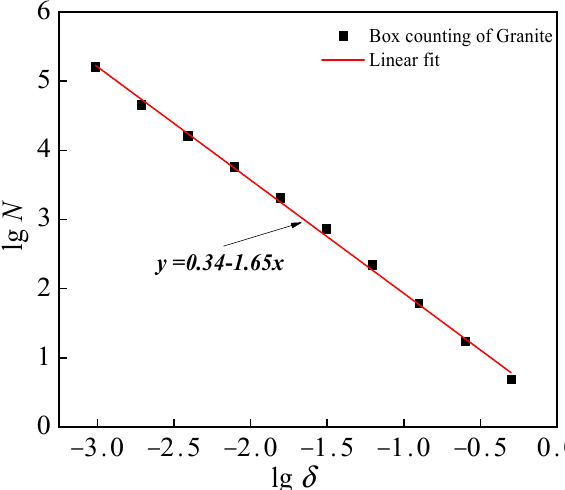
Figure 12. Box-counting method double logarithmic diagram for granite.